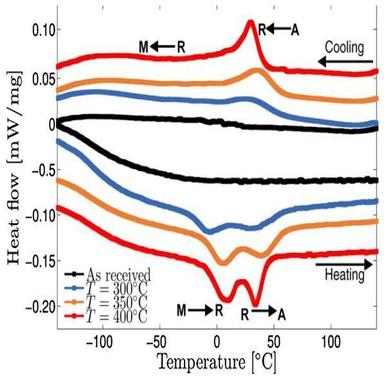
Differential scanning calorimetry test.